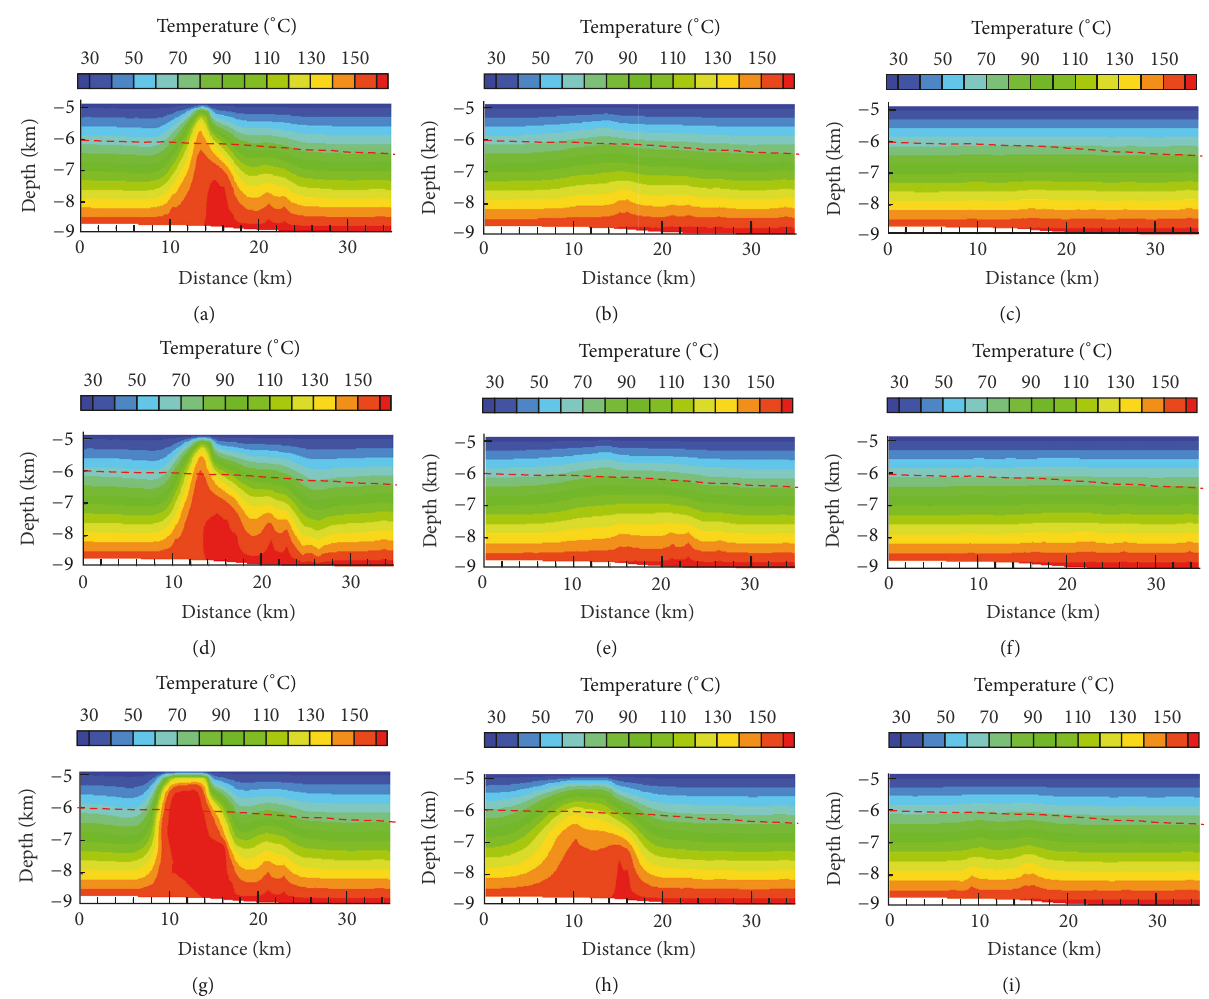
Figure 12: The temperature patterns of Scenario I: (a) 𝑘 h : 𝑘 v = 1 , (b) 𝑘 h : 𝑘 v = 10 , and (c) 𝑘 h : 𝑘 v = 100 ; Scenario II: (d) 𝑘 h : 𝑘 v = 1 , (e) 𝑘 𝑘 = 10 , and (f) 𝑘 𝑘 = 100 ; and Scenario III: (g) 𝑘 h : v h : v dashed lines which were arranged for plotting dissolved porosity in Figure